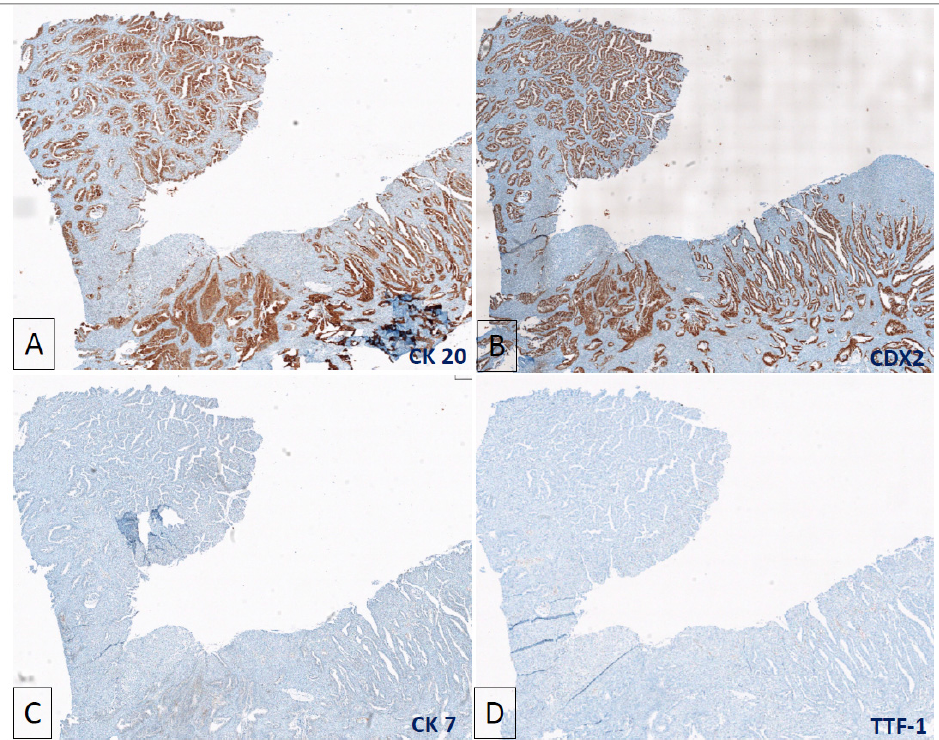
Figure 4. Immuno-stains of the previous colorectal carcinoma showing ( A ) strong and diffusely positive CK20 and ( B ) CDX2, and absence of CK7 ( C ) and TTF-1 ( D ).